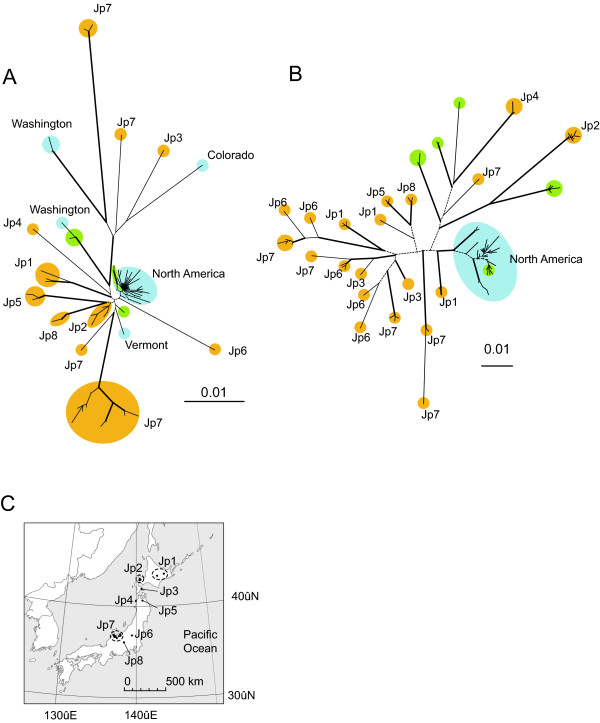
Greater absolute genetic divergences and regional divergences in unglaciated regions compared to glaciated regions for Daphnia rosea. Unrooted Neighbor-joining phylograms of mitochondrial ND2 gene sequences (A) and nuclear HSP90 gene sequences (B) for Japanese and North American D. rosea s.l. The HSP90 sequences are from a subset of specimens represented on the ND2 tree. Colors represent geographic location: blue (North America except for Alaska, USA and Yukon, Canada); green (Beringian North America, i.e. Alaska and Yukon); and gold (Japan). Thick branches have more than 70% bootstrap support, and dot branches have less than 50% bootstrap support. The map (C) shows Japanese regions (Jp1-8) and populations. Note the lack of sharing of nuclear and mitochondrial haplotypes among Japanese regions (Jp1-8).